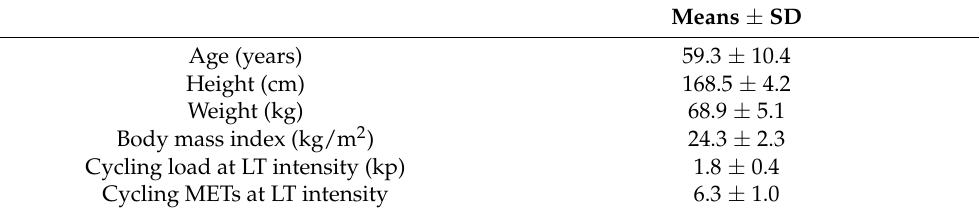
Table 1. Characteristics of the study subjects ( n = 7).